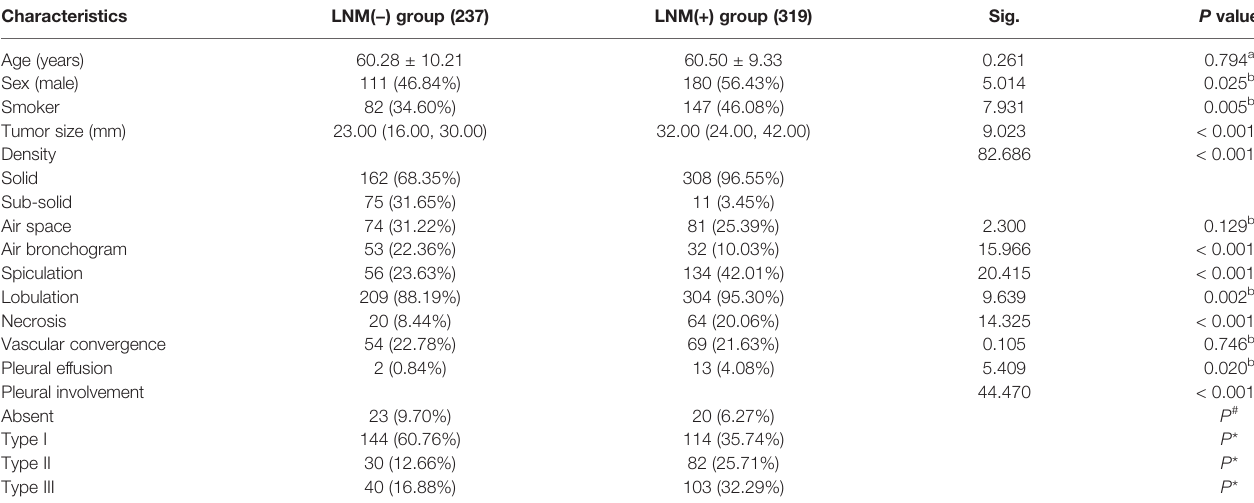
TABLE 1 | Comparison of the clinical characteristics and CT morphological features between the LNM ( − ) and LNM (+) groups (n, %).